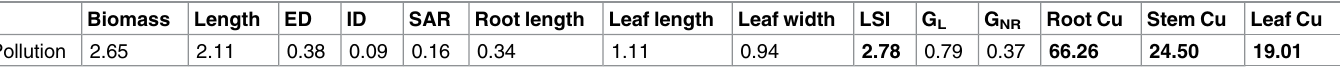
Abbreviations are described in the experiment and measurements section of the Materials and Methods. Length is the final total length of all stems. Root Cu, stem Cu and leaf Cu indicated the Cu contents in these tissues. F values are indicated, and the bold values indicate P < 0.05. Data were natural logarithm transformed prior to the